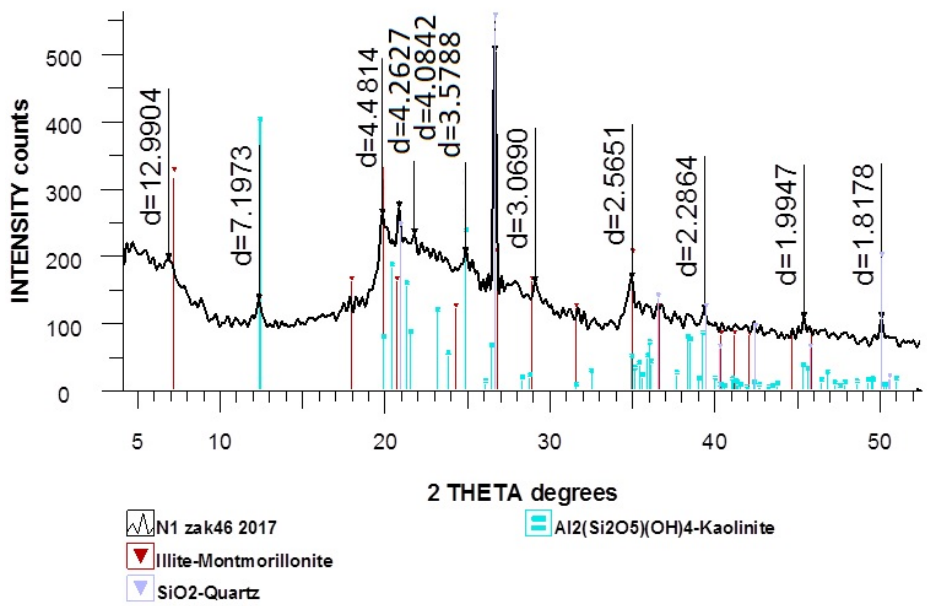
Figure 3. X-ray diffraction pattern of natural diatomite. On the X-ray pattern of the natural diatomite, the most characteristic line of quartz with a distance of 3.35 Å is visible, and there are several lines that characterize amorphous SiO 2 with inter-planar distances of 2.49 and 4.26 Å, as well as lines with inter-planar dis- tances of 3.03, 3.28 and 3.39 Å, which indicate the presence of calcite in the sample.